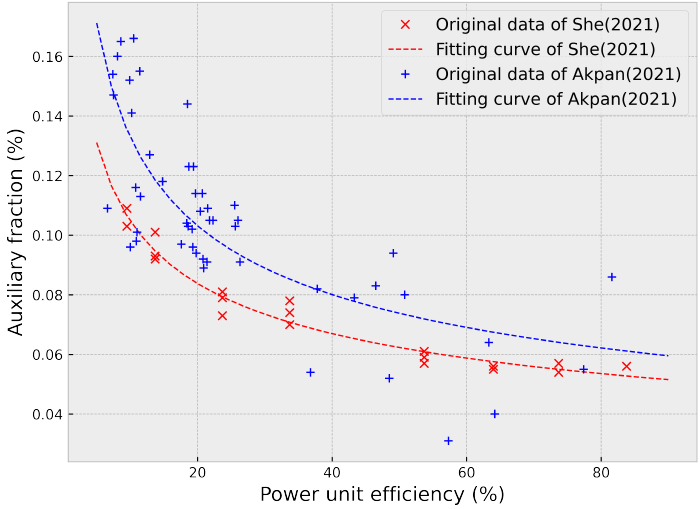
Figure 8. The relationship between auxiliary load fraction and efficiency of net generation